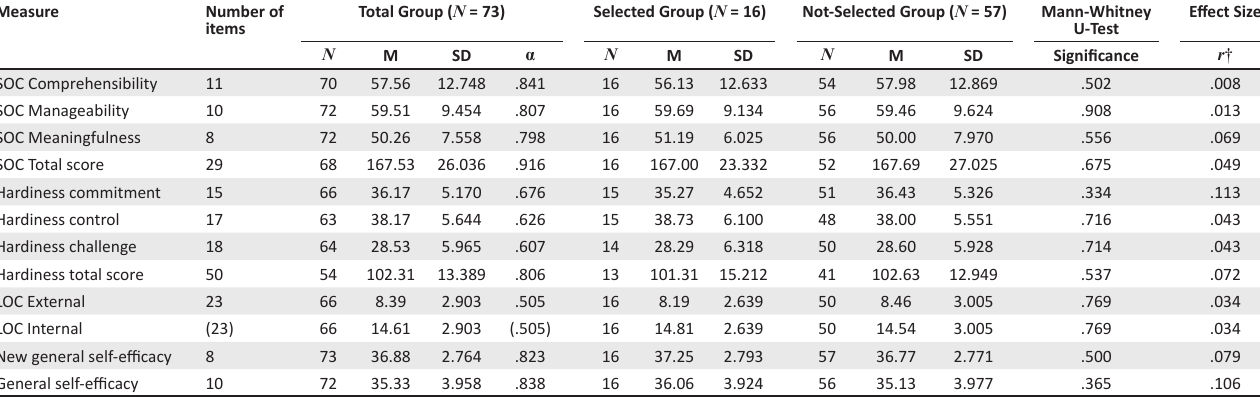
TABLE 2: Quantitative results for the total sample group and for the comparison of the selected ( N = 16) and the not-selected ( N = 57) groups. Measure Number of Selected Group ( N = items